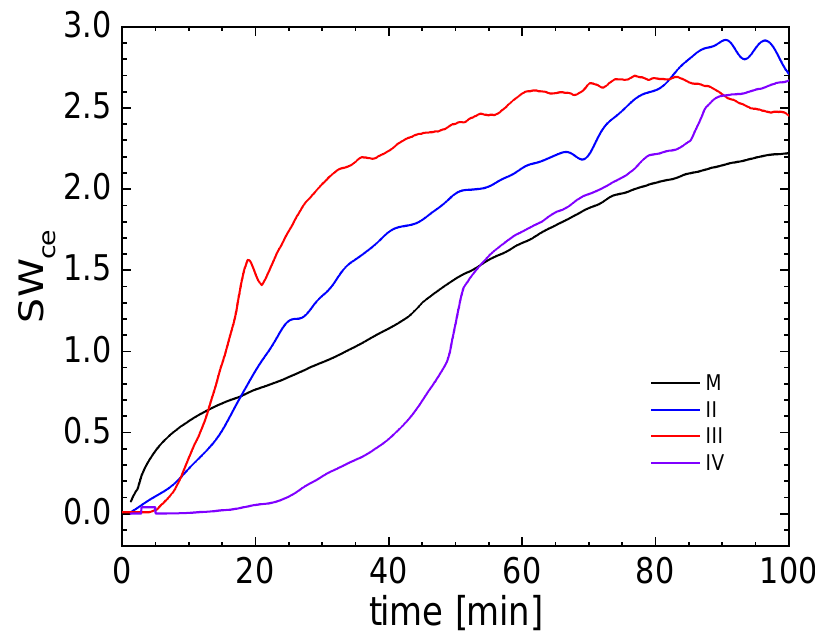
Figure 7. Rescaled swelling ratio evaluated from electric conductivity measurement in the initial time regime for the control sample M and samples with an increased quantity of GO (II, III, and IV).